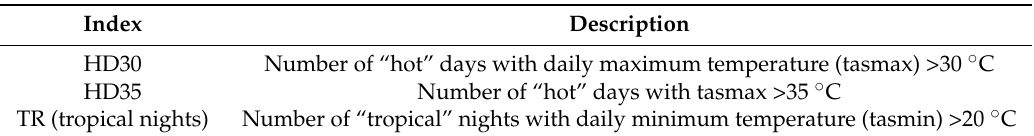
Table 1. Temperature indices for evaluation of downscaled data in relation to Salmonella incidences; temporal scale for the index (week, month, year) depends on the application.